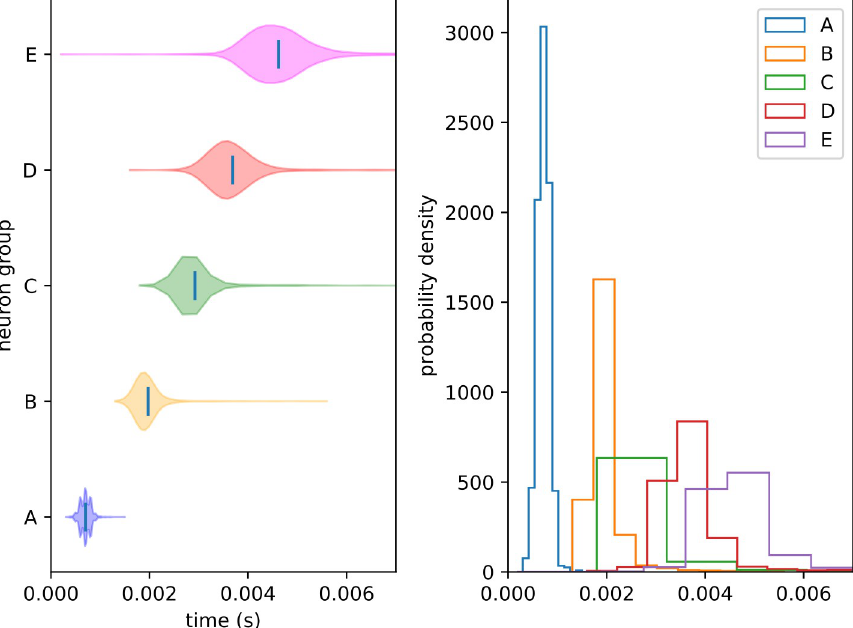
Fig 9. Control peak distributions. Distribution of peak recall times for each element in the control condition (i.e. undistracted recall). Plot (A) shows this as a violin plot (densities estimated with a 50 point Gaussian kernel) and plot (B) as overlapping histograms. Times are given relative to cue onset. The reliable ordering indicates a clear recall of the trained sequence.